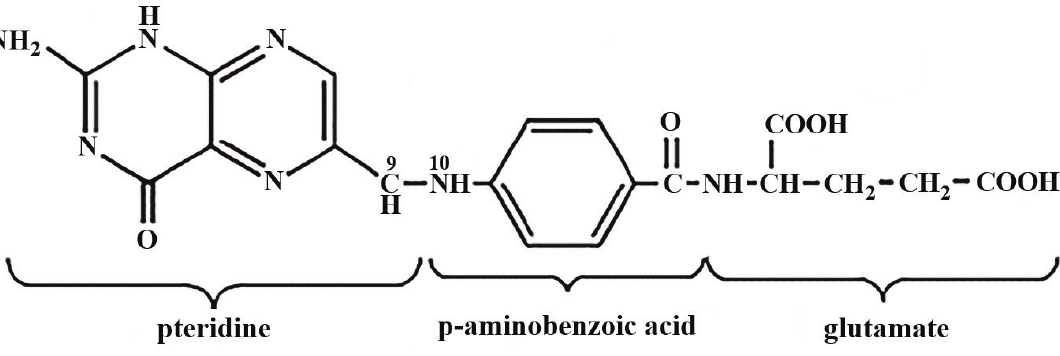
Figure 3. Structural formula of folic acid